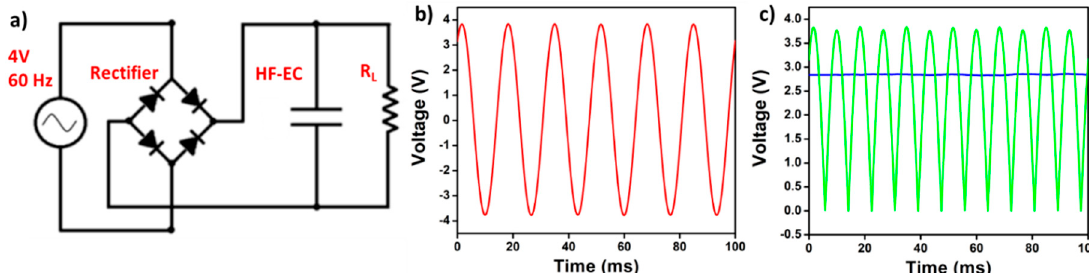
Figure 5. Demonstration of AC line filtering function of HF-EC using VG/CMF electrodes: ( a ) AC/DC conversion circuit diagram, ( b ) a 60 Hz sine wave signal with 4 V amplitude used as the input, and ( c ) the output from the rectifier with (blue line) and without (green curve) filtering capacitor. Reproduced with permission from Ref. [9], Copyright 2019, Elsevier.